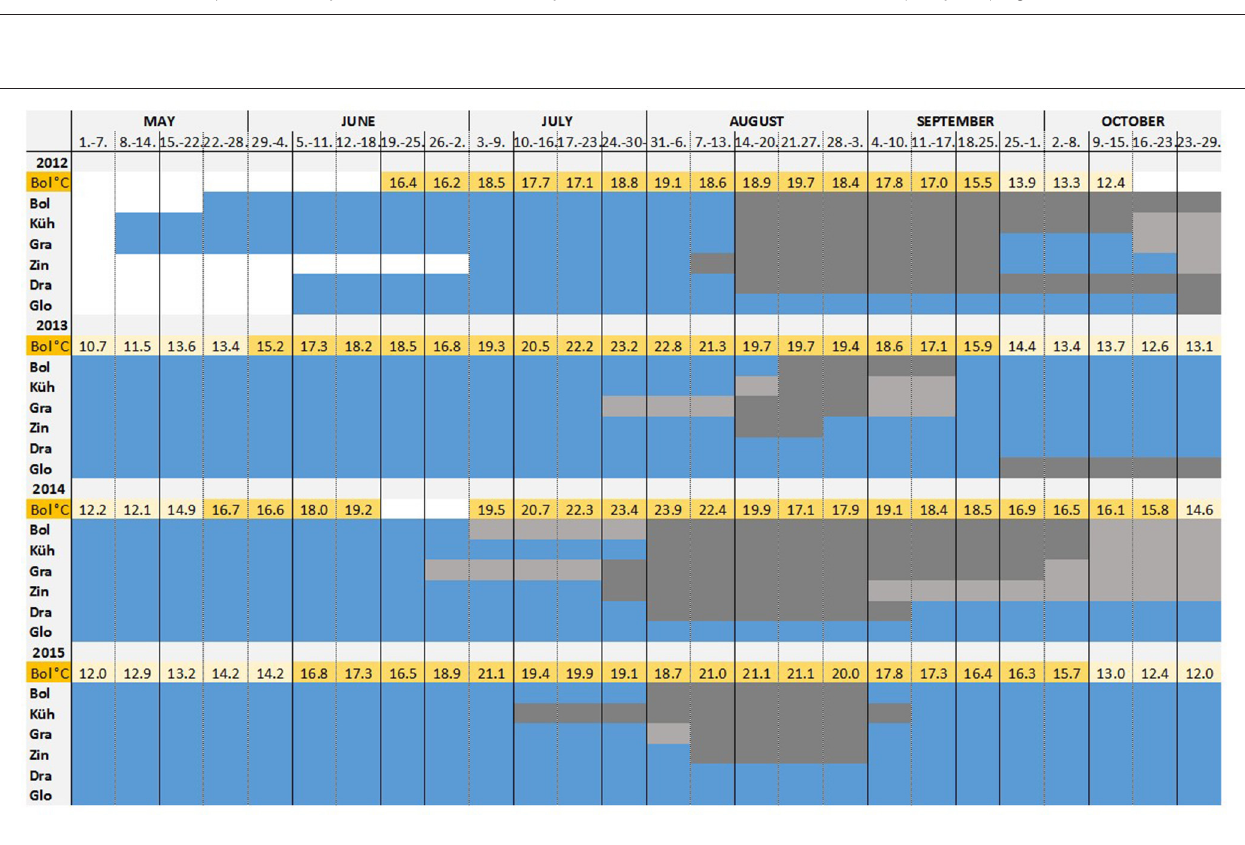
FIGURE 5 | Larvae abundance: Bars indicate the median ( n = 3) number of boreholes counted per dm 2 on test panels at the different sampling sites in the years 2012–2015. Panels were exposed from May to October. The mean salinity based on measurements from 2012 to 2015 (hourly data) is given above the bars.